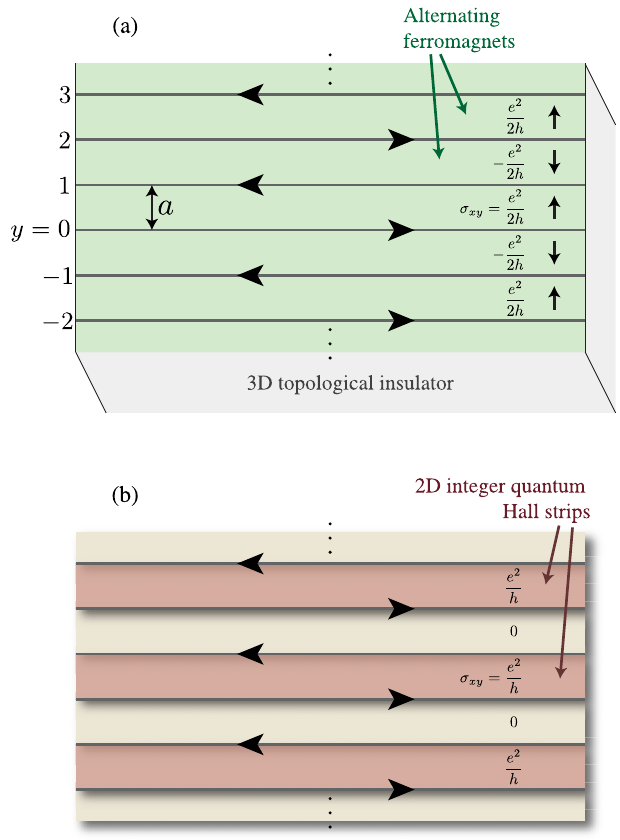
FIG. 2. (a) Strongly interacting coupled-chain setup analyzed in this paper. Ferromagnetic strips of alternating magnetization reside on a 3D topological insulator surface. Within each domain the electrons are gapped and exhibit a surface Hall conductance of σ xy ¼ (cid:2) e 2 = ð 2 h Þ . The domain walls, however, bind an array of gapless 1D electron modes with staggered chirality. Importantly, the surface remains invariant under the symmetry ing to time reversal composed with a translation by half a unit cell. (b) The same set of gapless 1D modes arising in a strictly 2D setup consisting of ν ¼ 1 integer quantum Hall strips separated by insulators. Contrary to the surface in (a), here always explicitly